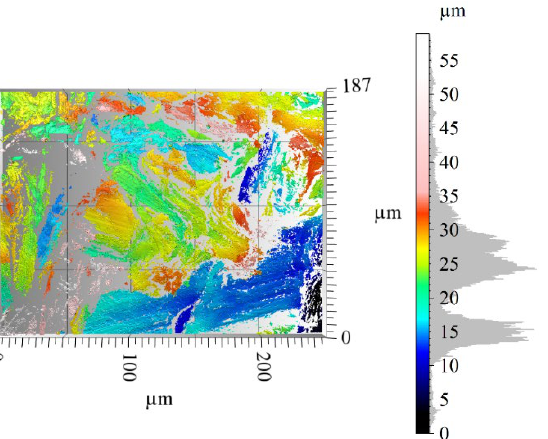
Figure 8. Three-dimensional view of the stitched topography in test case A. Stitching size: 2 × 2.